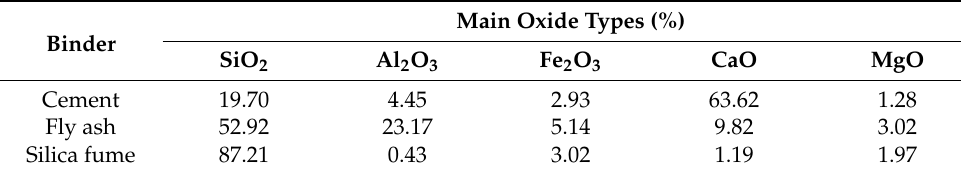
Table 1. Chemical composition of the major materials.